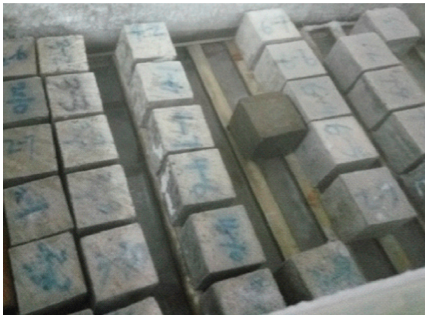
Figure 2: Cement mortar